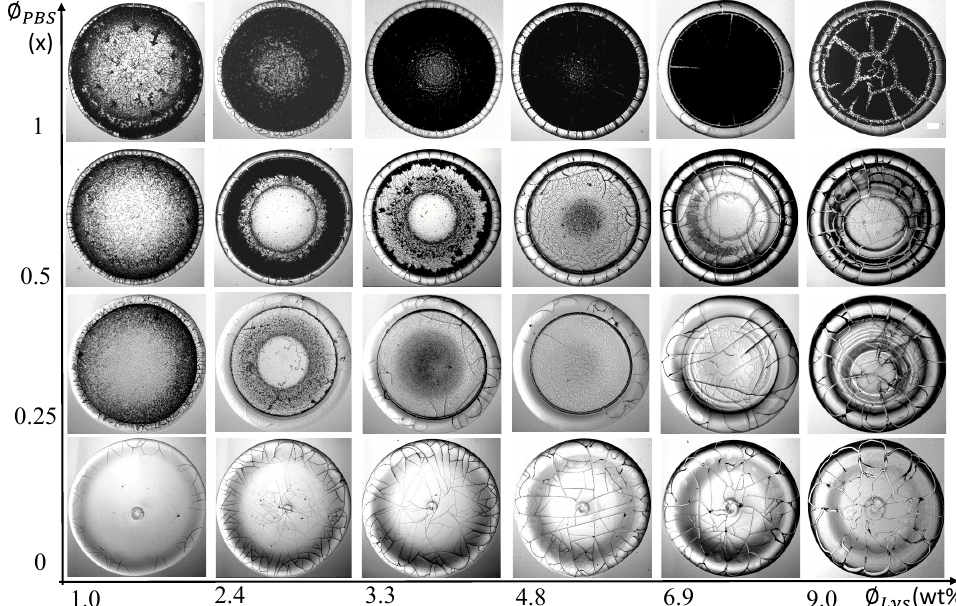
Figure 3. Morphological patterns observed in the drying drops of Lys are exhibited here. These patterns are detected for the various initial concentrations of Lys ( φ Lys ) dissolved in the initial concentrations of the phosphate buffer saline ( φ PBS ). The φ PBS = 0 × indicates that the solution is prepared in de-ionized water. The scale bar is of a length of 0.15